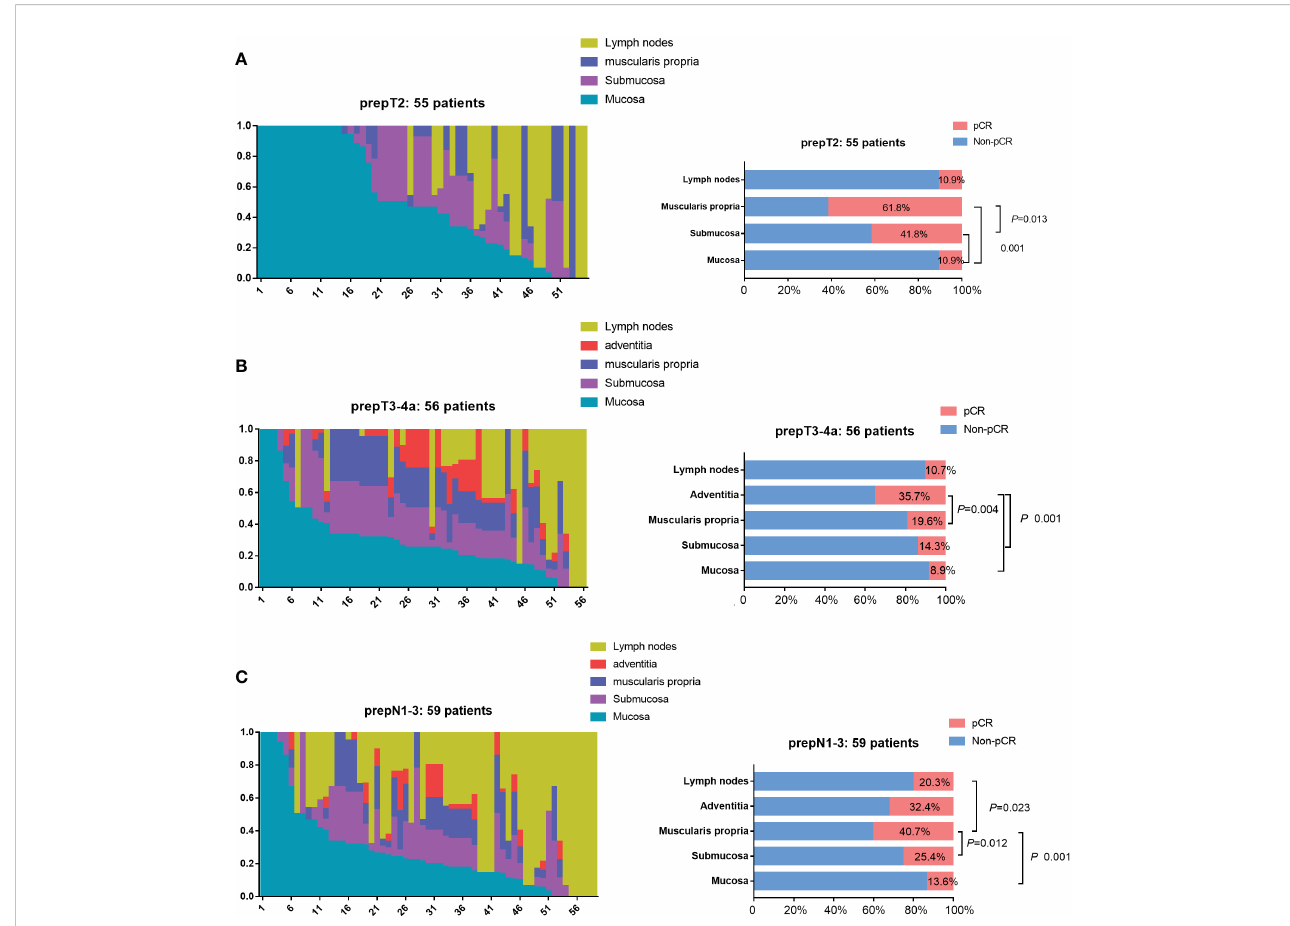
FIGURE 3 Residual tumor location in nonpCR patients. (A) The distribution of residual tumor cells within 3 esophageal wall layers (mucosa, submucosa, muscularis propria) and lymph nodes in 55 prepT2 nonpCR patients. Residual tumors in the mucosa and/or submucosa were found in 52 (94.6%) of 55 patients. The mucosa had residual tumor cells signi fi cantly more frequently than the submucosa and muscularis propria ( P <0.001). (B) The distribution of residual tumor cells within 4 esophageal wall layers (mucosa, submucosa, muscularis propria, adventitia) and lymph nodes in 56 prepT3-4a nonpCR patients. Residual tumors in the mucosa and/or submucosa were found in 53 (94.6%) of 56 patients. The mucosa, submucosa, and muscularis propria had residual tumor cells signi fi cantly more frequentlythan the adventitia ( P <0.005). (C) The distribution of residual tumor cells within 4 esophageal wall layers (mucosa, submucosa, muscularis propria, adventitia) and lymph nodes in 59 N1-N3 nonpCR patients. Residual tumors in the mucosa and/or submucosa were found in 54 (91.5%) of 59 patients. The mucosa, submucosa, and lymph nodes had residual tumor cells signi fi cantly more frequently than the muscularis propria